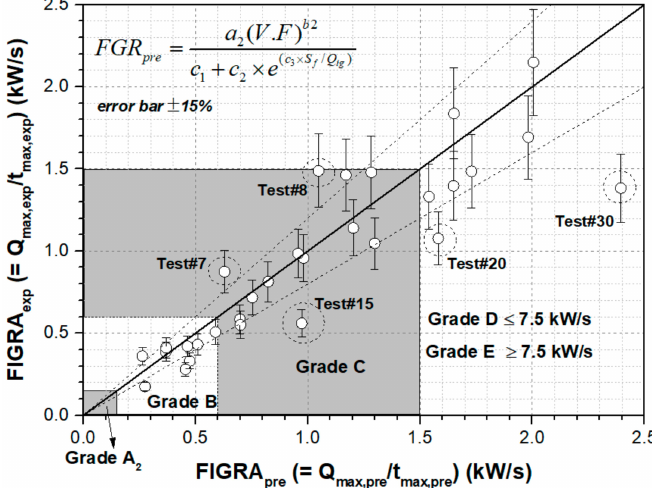
Figure 13. The comparison of the predictions and experiment of the fire growth rate index with scale factors ( S f = 1 / 3, 1 / 4, and 1 / 5), volume fraction ( VF = 0.024, 0.05, 0.07, and 0.1), and ignition heat sources ( Q ig